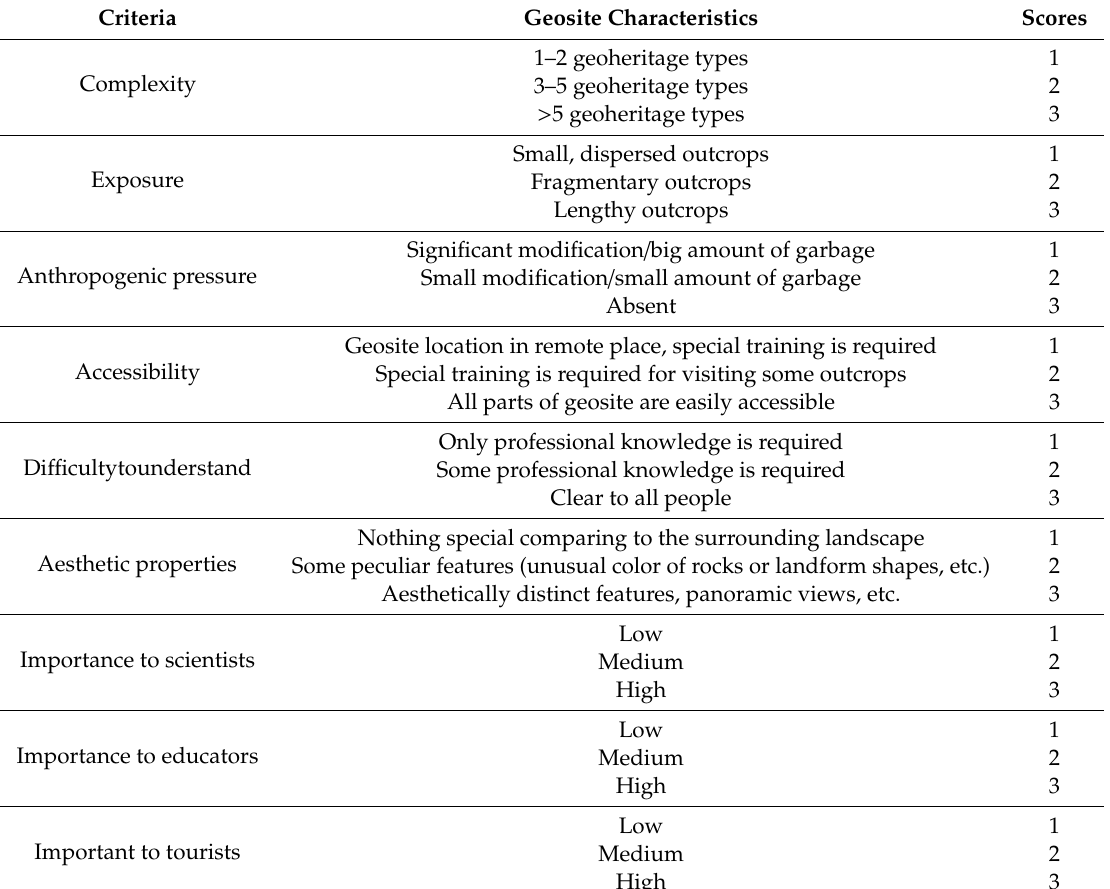
Table 1. Criteria used for geositeevaluation in this